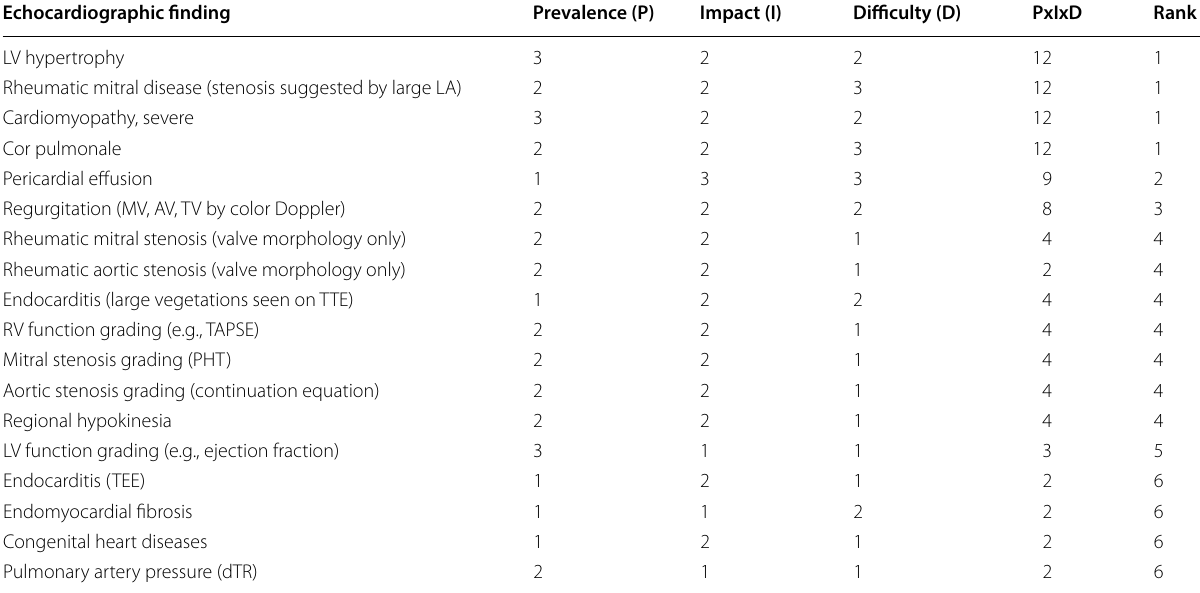
For prevalence and impact the numbers indicate the following levels: 1 low, 2 medium, 3 high. For difficulty, scoring is reversed with numbers indicating the = = = following levels: 1 high, 2 medium, and 3 low. This allows for a composite score where the higher numbers = = = correspond to increasing relevance and applicability of POCUS LV left ventricular, LA left atrium, MV mitral valve, AV aortic valve, TV tricuspid valve, TEE transesophageal echocardiogram, RV right ventricle, TAPSE tricuspid annular plane systolic excursion, PHT pressure half-time, dTR pressure gradient measured in tricuspid